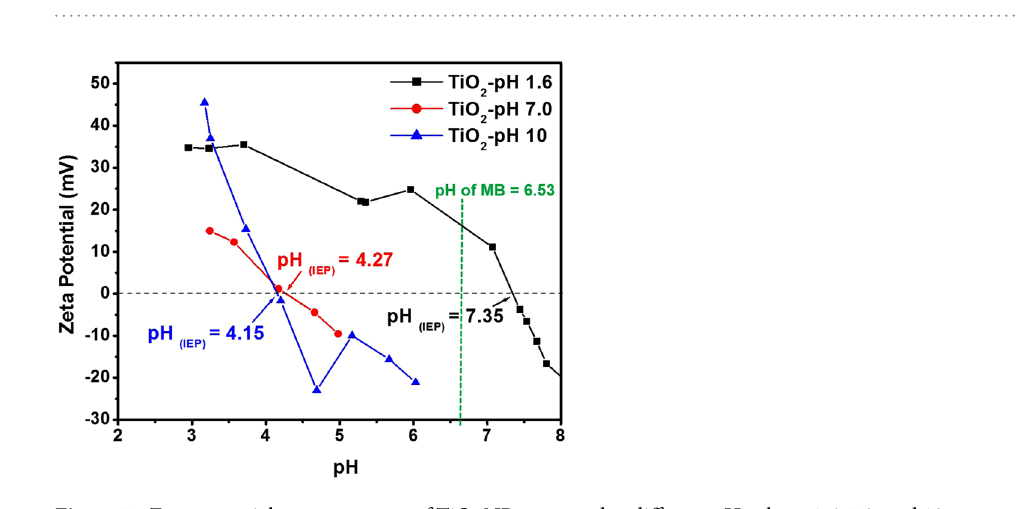
Figure 6. Adsorption kinetics of MB dye on TiO 2 NPs surface prepared at different pH values; 1.6, 7.0 and 10.